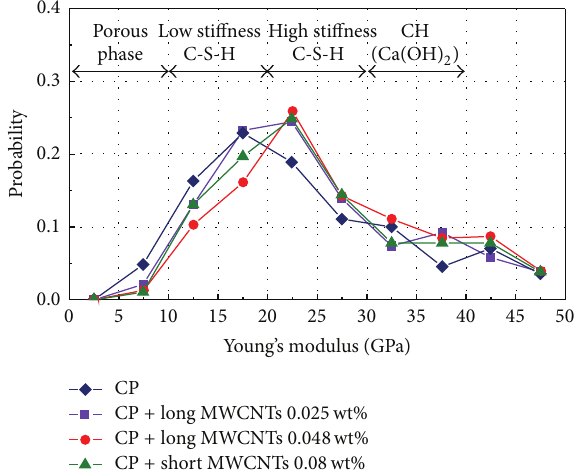
Figure 7: Probability pots of Young’s modulus of cement paste reinforced with CNTs